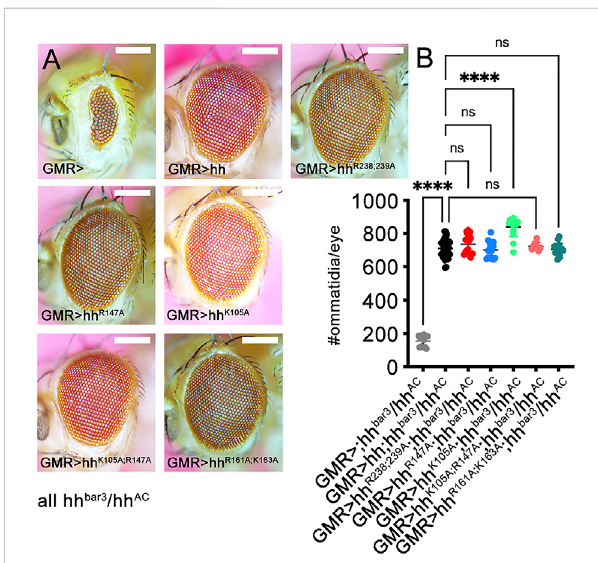
FIGURE 3 Hh short-range activity in vivo does not depend on established HS binding amino acids. Short-range Hh signaling in the eye disc determines the number of photoreceptors (ommatidia) in the adult Drosophila eye. (A) Discs lacking most Hh expression (hh bar3 / hh AC ) develop into small eyes (GMR > ), but GMR-Gal4-controlled expression of hh and all tested hh variants restore eye development in this background. (B) Quanti fi cation of phenotypes. One-way ANOVA, two-tailed, Dunnett`s multiple comparisons post hoc test. ****: p < 0.0001, n.s, not signi fi cant ( p > 0.046). No signi fi cant sex differences